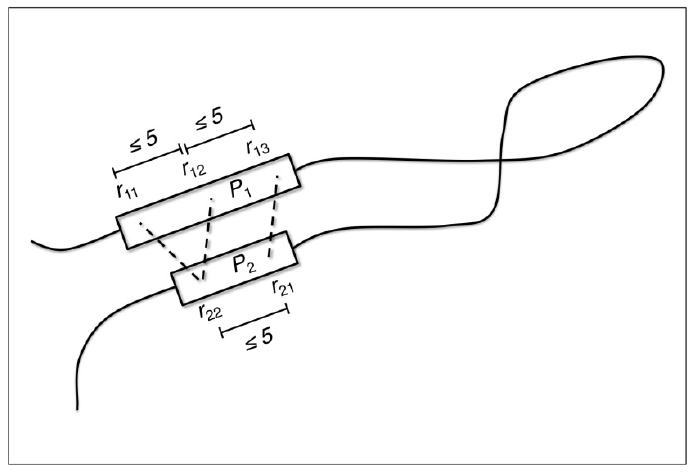
and P , respectively, combine to form a 2 + 3 1 2 and P must be at least 6 residues apart along 1 2 − r ≥ 21 13